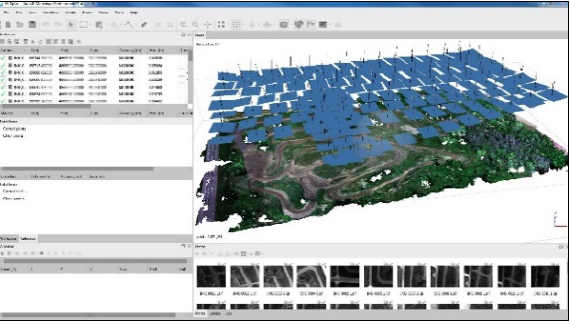
Figure 7: Agisoft Photoscan Project